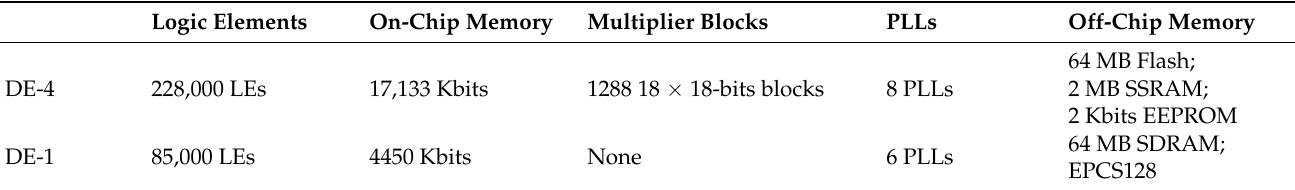
Table 2. Logic resources of the DE-4 and DE-1 FPGA boards.